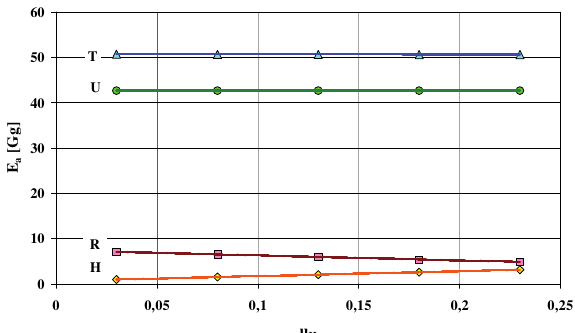
Fig. 9. Dependence of the national annual emission of volatile organic compounds from passenger cars upon the road length travelled under the